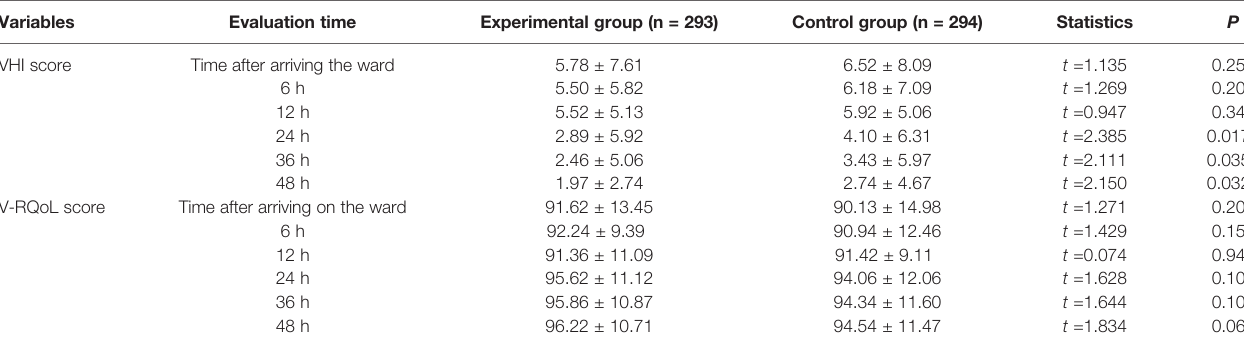
TABLE 4 | Comparison of voice change scores between the two groups. Variables